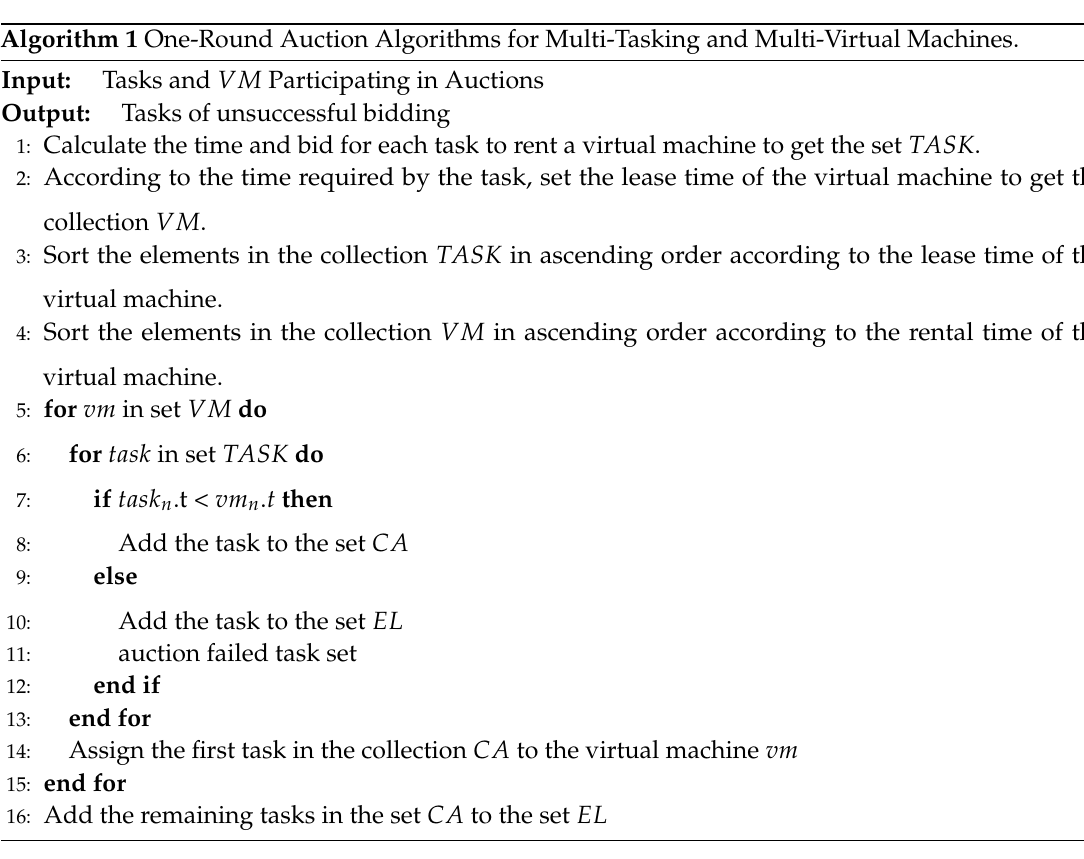
Algorithm 1 One-Round Auction Algorithms for Multi-Tasking and Multi-Virtual